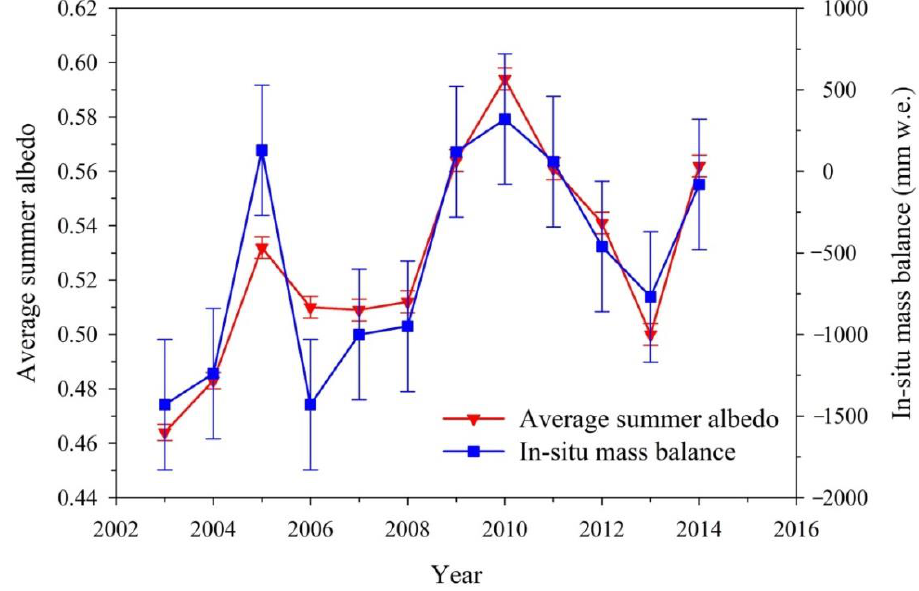
Figure 4. The average summer albedo and in situ mass balance for the Chhota Shigri glacier from 2003 to 2014.